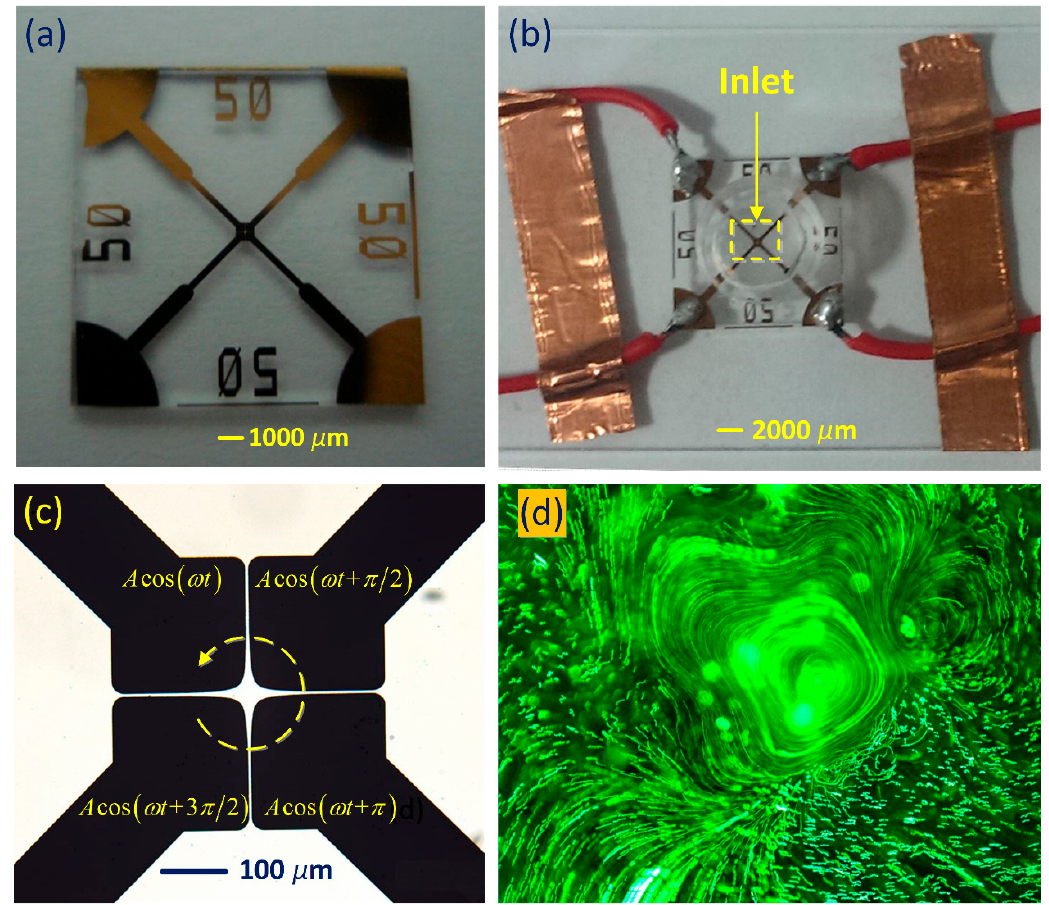
Figure 1. Experimental setup of the microfluidic chip for studying the behavior of electrothermal flow in a rotating electric field (ROT-ETF). ( a ) An optical micrograph of the four-phase polynomial electrode configuration employed in this work; ( b ) A picture of the experimental microfluidic device where Plant Design Management System (PDMS) microchamber is plasmally bonded to the glass substrate with desired circulating electrode patterns; ( c ) Schematic of the applied 90°-phase-shifted sinusoidal voltage waves that produce a counterclockwise rotating electric field above the cross-shaped interelectrode gaps; ( d ) The fully-developed co-field TWET induction whirlpool above the electrode array at the Debye frequency of electrolyte suspension.